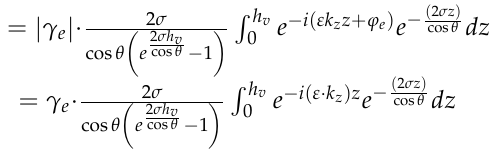
is the height reduction at the 2